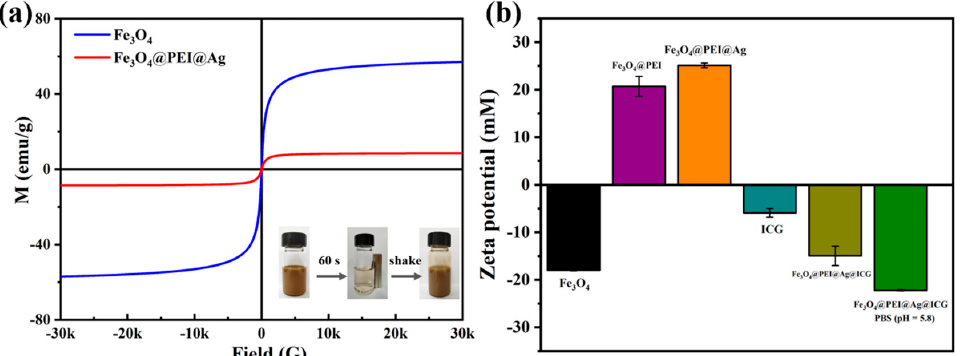
Figure 2. ( a ) Magnetic properties of Fe 3 O 4 and Fe 3 O 4 @PEI@Ag structure (300 K), and the inset image is the checking in outer magnetism functions. ( b ) Zeta potentials of the intermediate and final prod- uct.